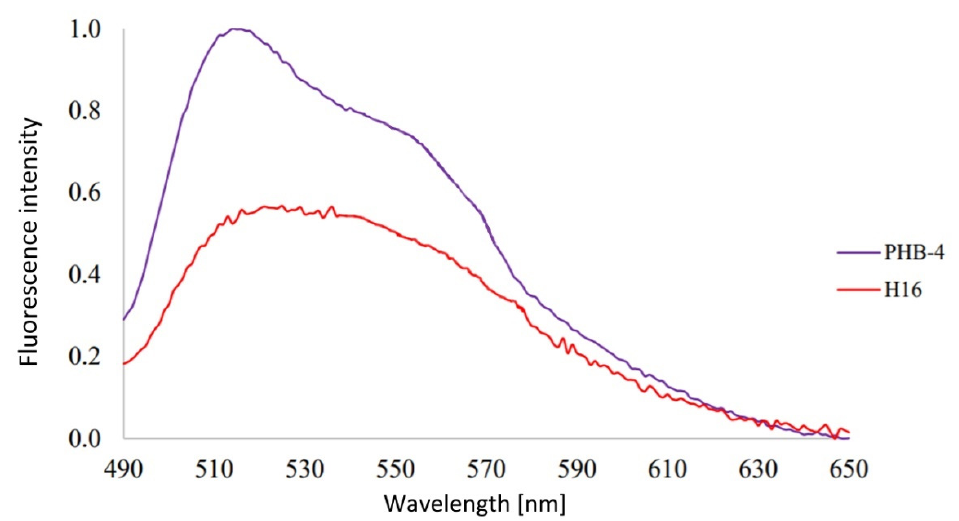
Figure 2. Emission spectra of the two Cupriavidus necator cultures used in this study. The concentration of the cells—10 6 cells in 1 mL PBS (phosphate buffered saline) buffer, 7.4 pH, with 467 nm excitation.